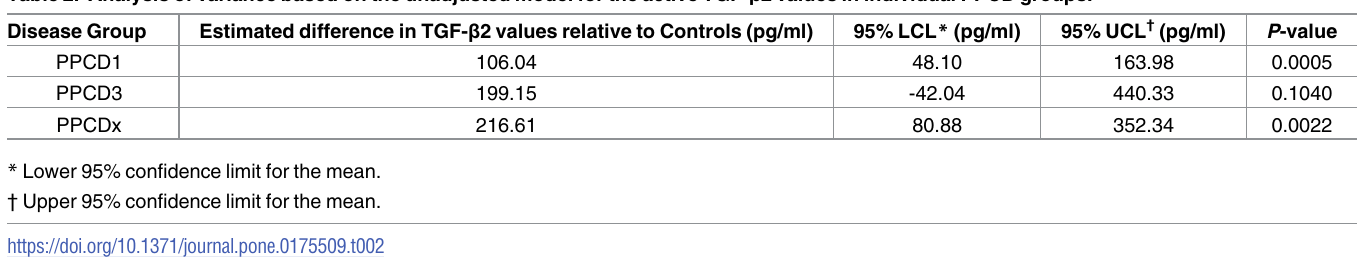
active TGF- β 2 in the AH of PPCD patients. We found that the mean concentration of TGF- β 2 in the AH of PPCD patients is significantly higher compared to that of the control group. The levels of TGF- β 2 were not altered by gender, age, secondary glaucoma or the progression of dystrophy to a clinical state in which PK was necessary.